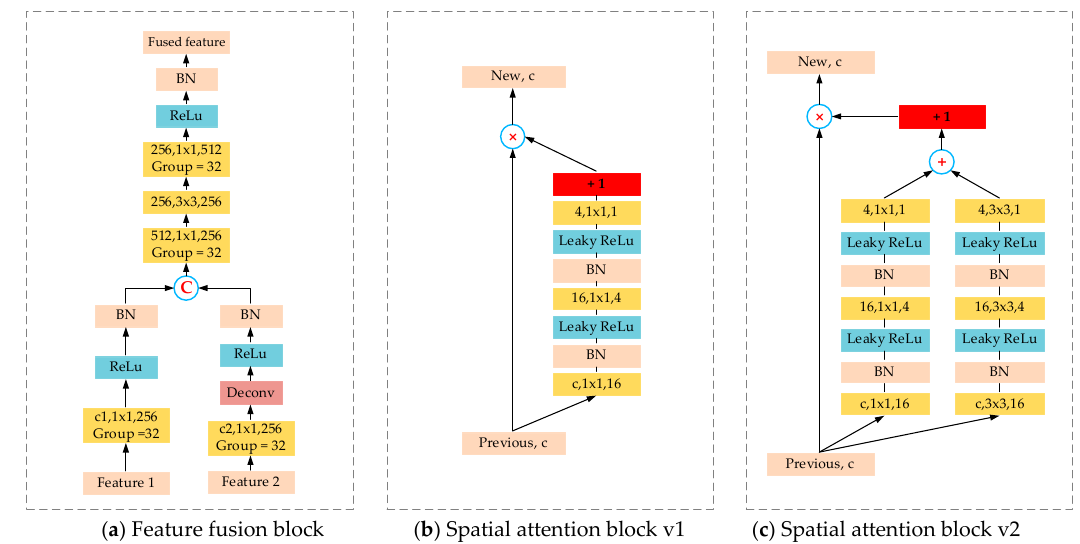
Figure 4. Feature fusion block and spatial attention block. The operation of “+1” is equivalent to residual connection.